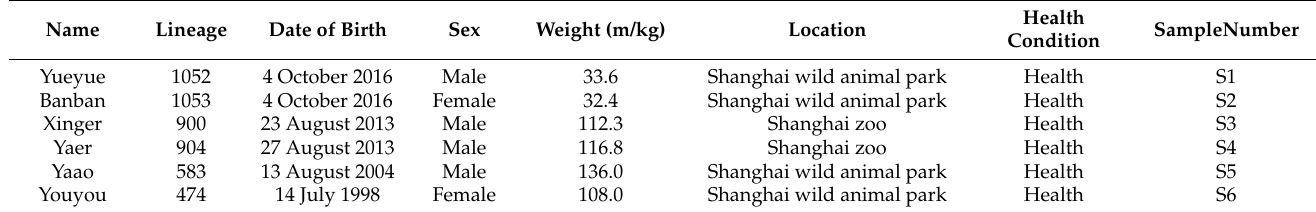
Table 1. Results of basic information of experimental giant